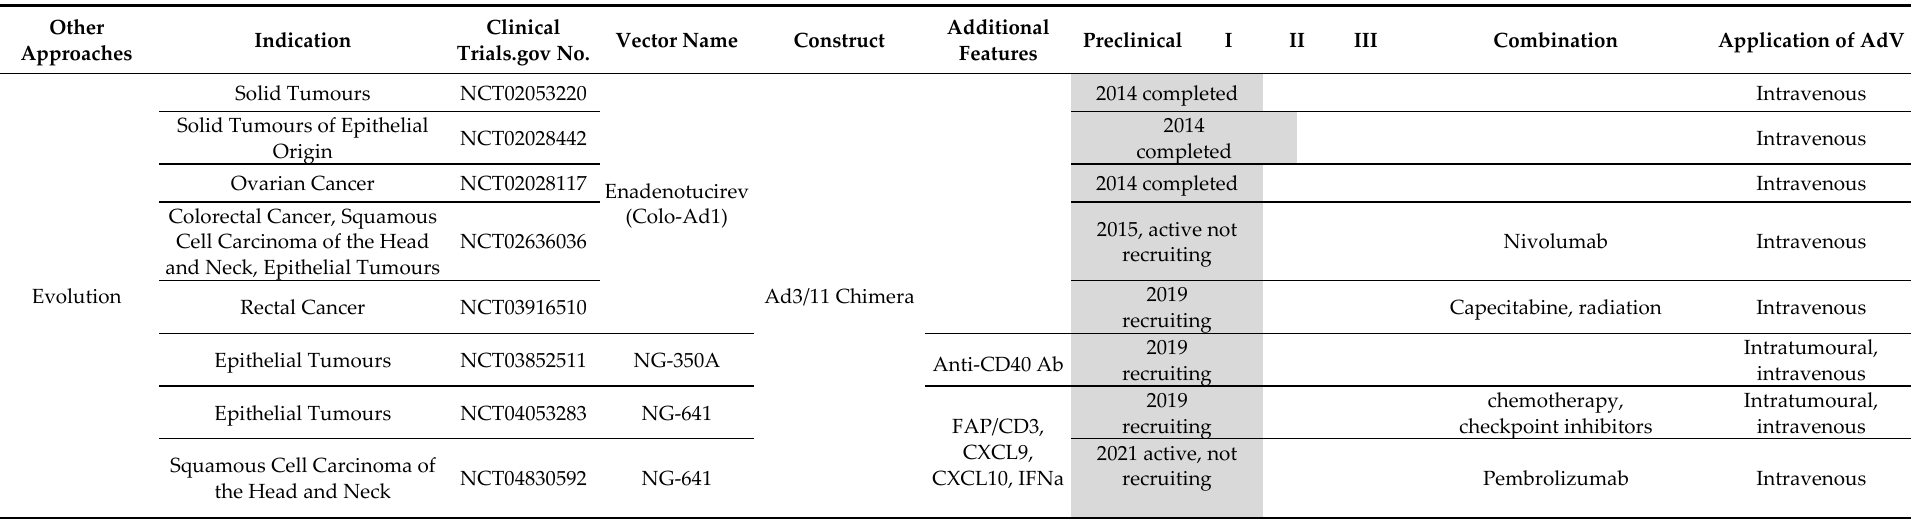
Table 5. Clinical trials using the vector enadenotucirev (Colo-Ad1), a vector whose specificity is based on selection in colon carcinoma.